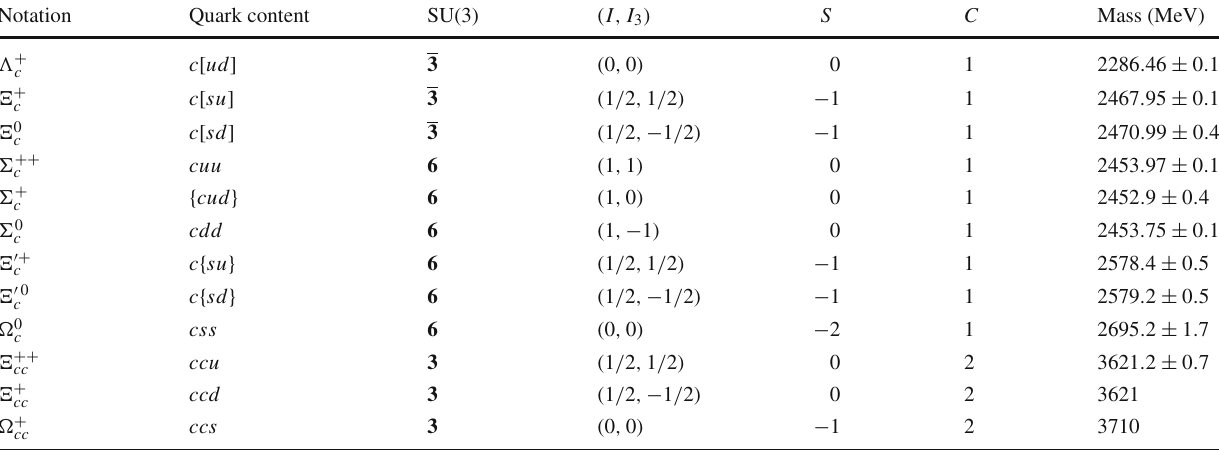
Table 1 Ground state charm baryon states with J P = 1 / 2 + . The square and curly brackets [ ab ] and { ab } denote antisymmetric and symmetric flavor label combinations